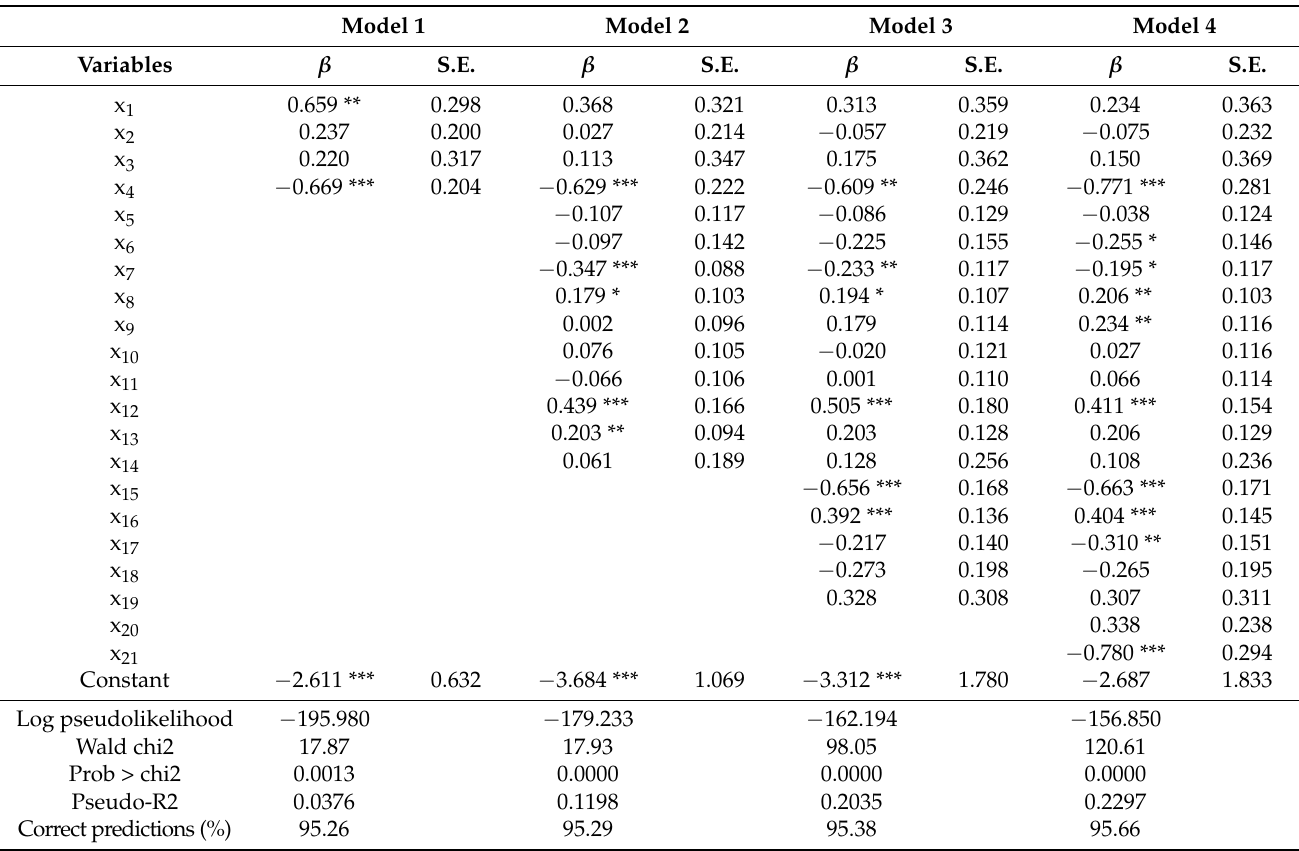
Table 9. Logistic regression for both types of new-to-the-market innovations together (y 3